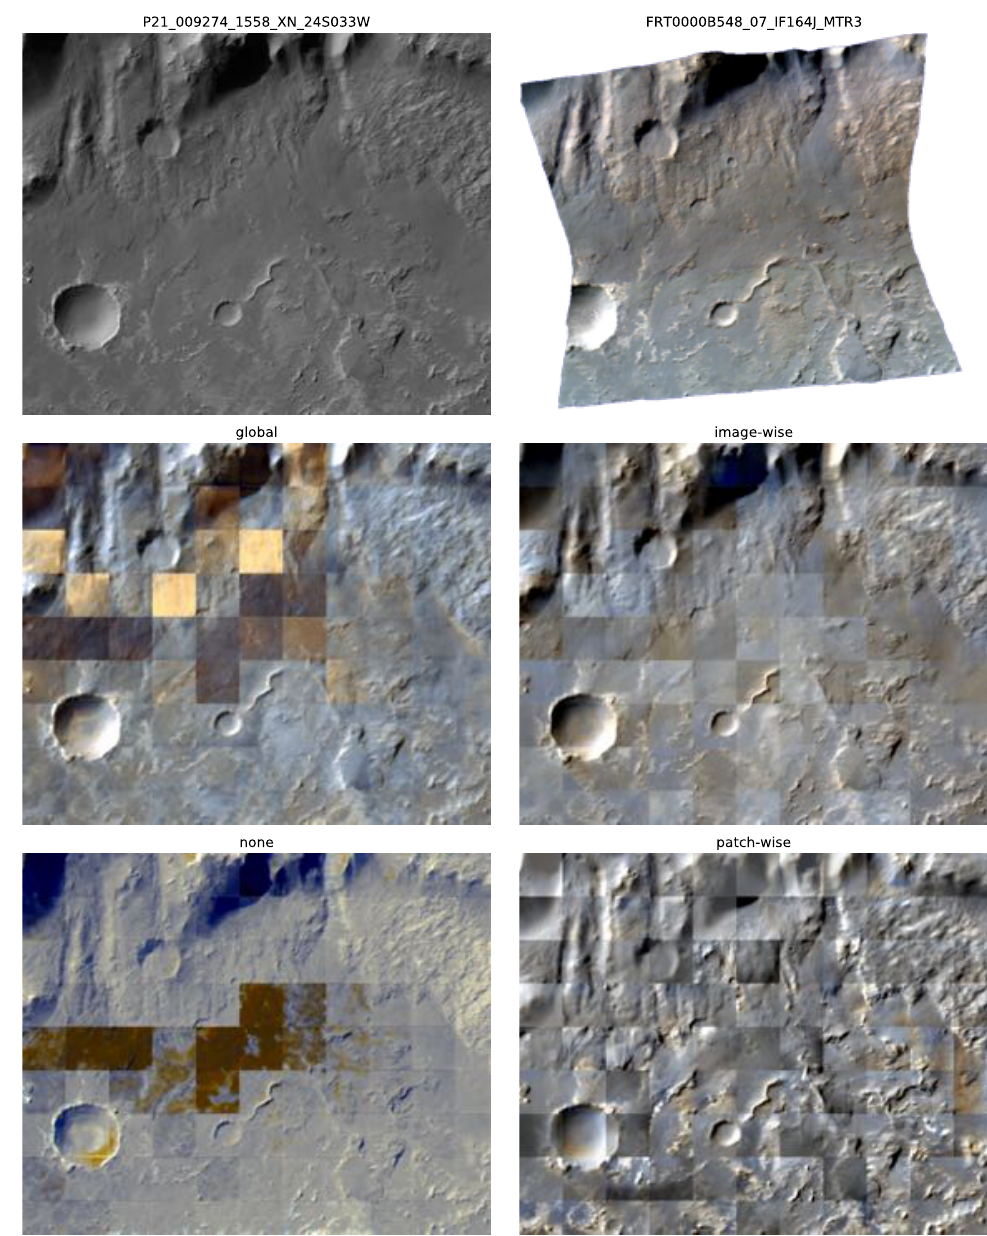
Figure 13. Full CTX-CRISM EVC image pair ( top row ) and model predictions with different normal- ization methods ( middle and bottom row